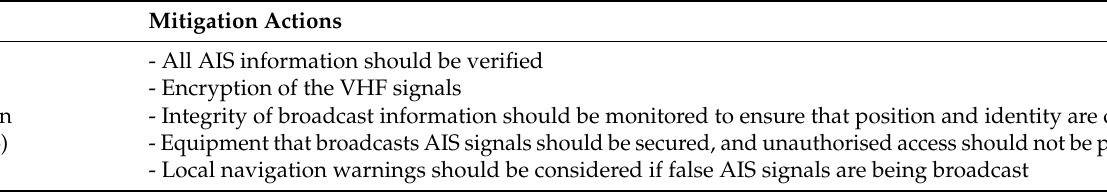
Table 4. A summary of possible mitigation